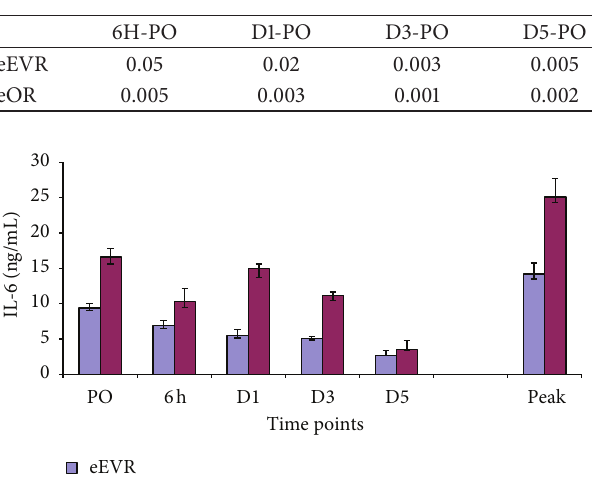
Table 1: Within-group comparison of CRP concentrations.